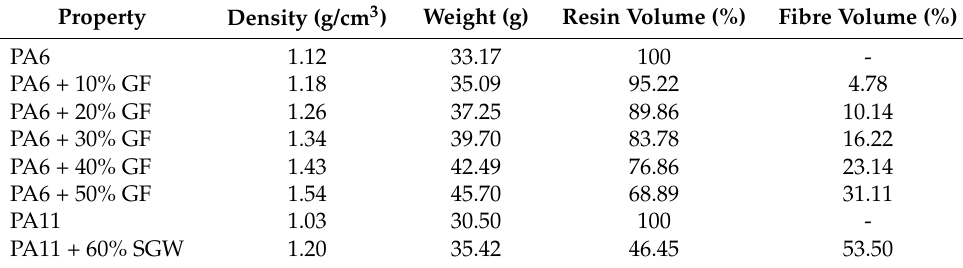
Table 3. Selected properties of pedals consisting of various composites.